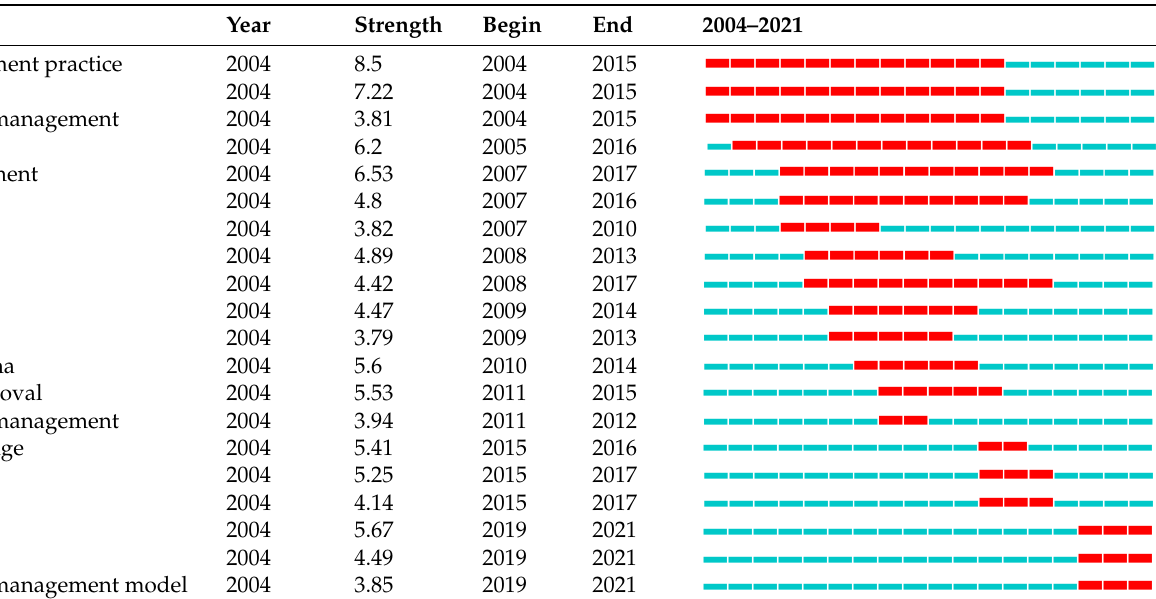
Table 3. The high-frequency keywords of publications according to the WOS database.